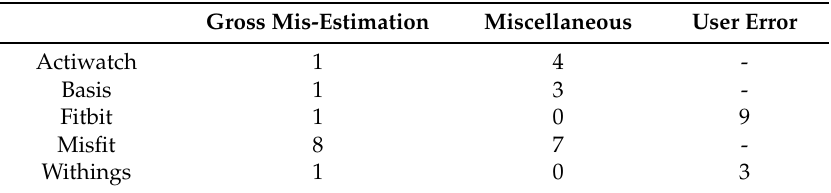
Table 2. Reasons for Device Failure.